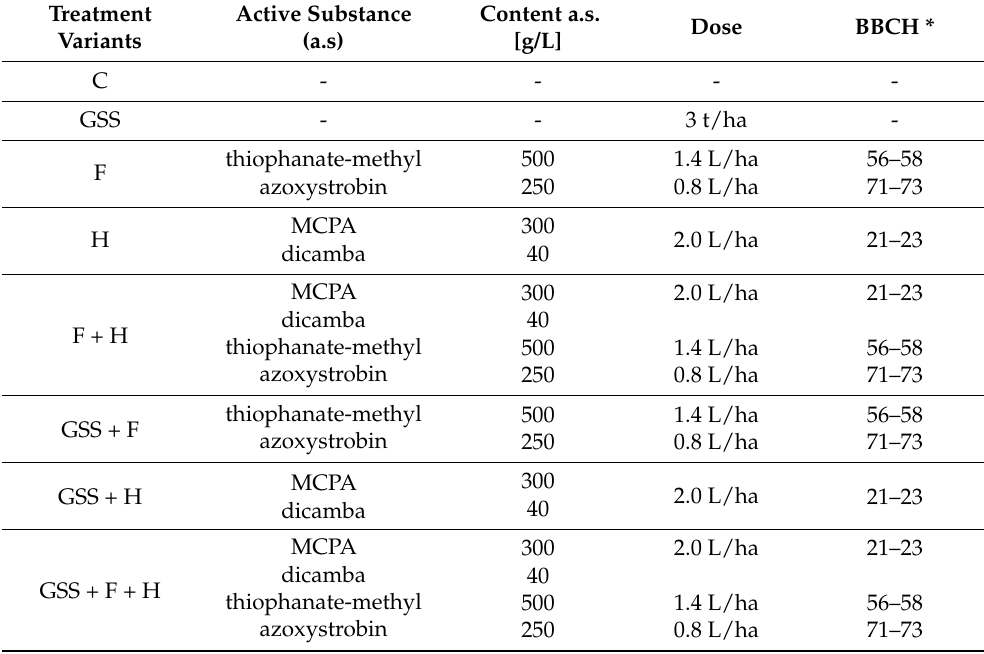
Table 1. The chemical protection treatment